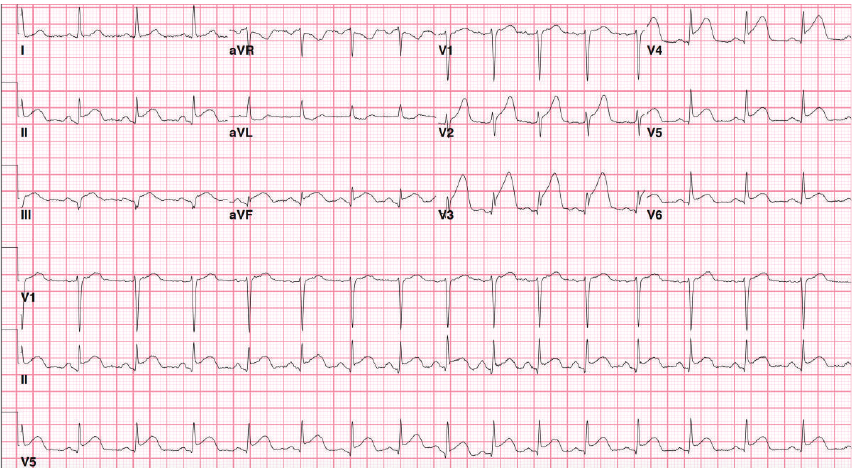
Figure 1: Initial ECG showing ST elevations in V2–V5, II, III, and AVF which are consistent with anterolateral and inferior STEMI.